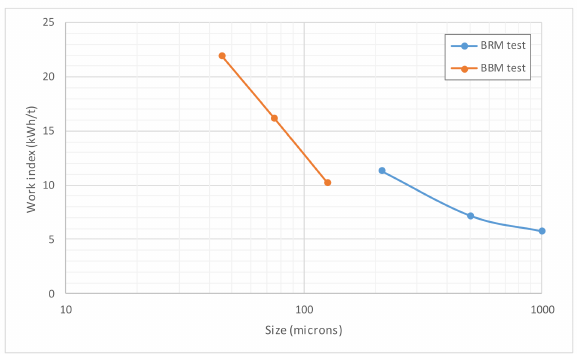
Figure 4. Variation of BBM and BRM w i values with P 100 , Penouta mine